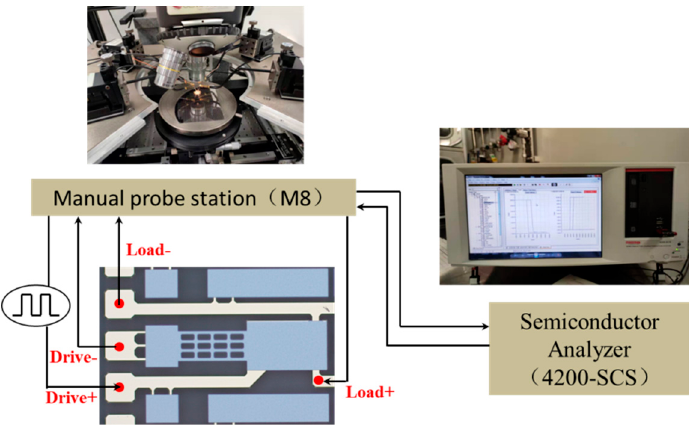
Figure 14. The setup schematic for measuring the contact lifetime.